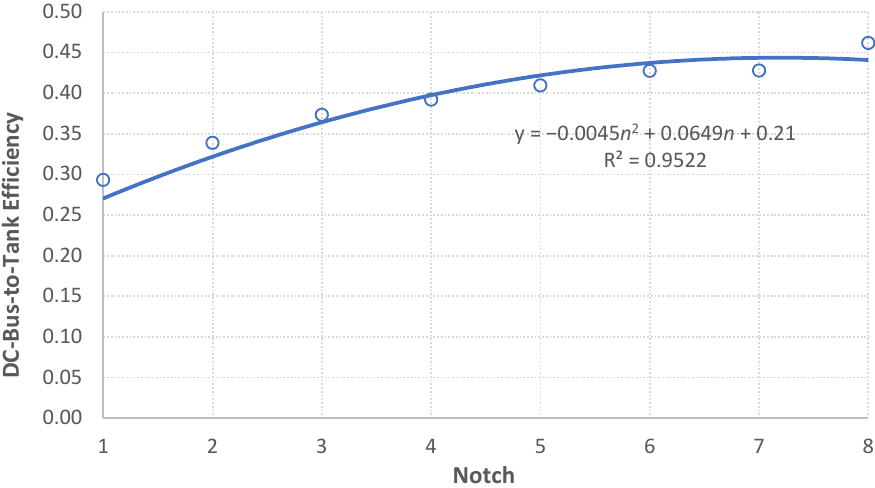
Figure 4. Estimated DC-bus-to-tank efficiency as a function of the notch position.